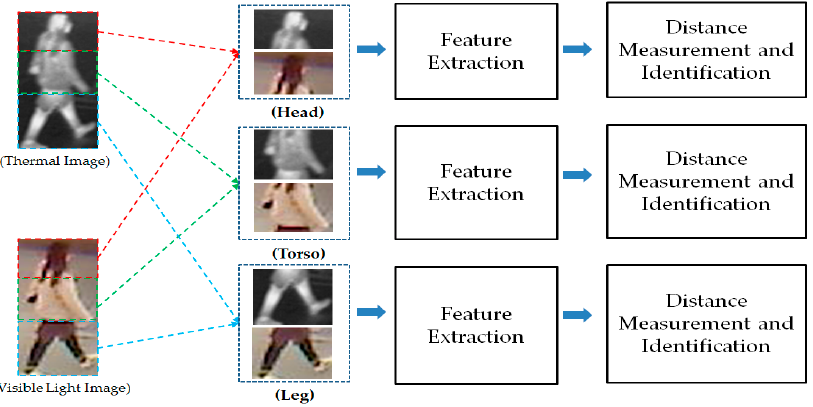
Figure 16. The separated body parts used in our experiments in this section. Table 8. Verification performance (EERs) of the systems that use body parts for the recognition (unit: %). Body